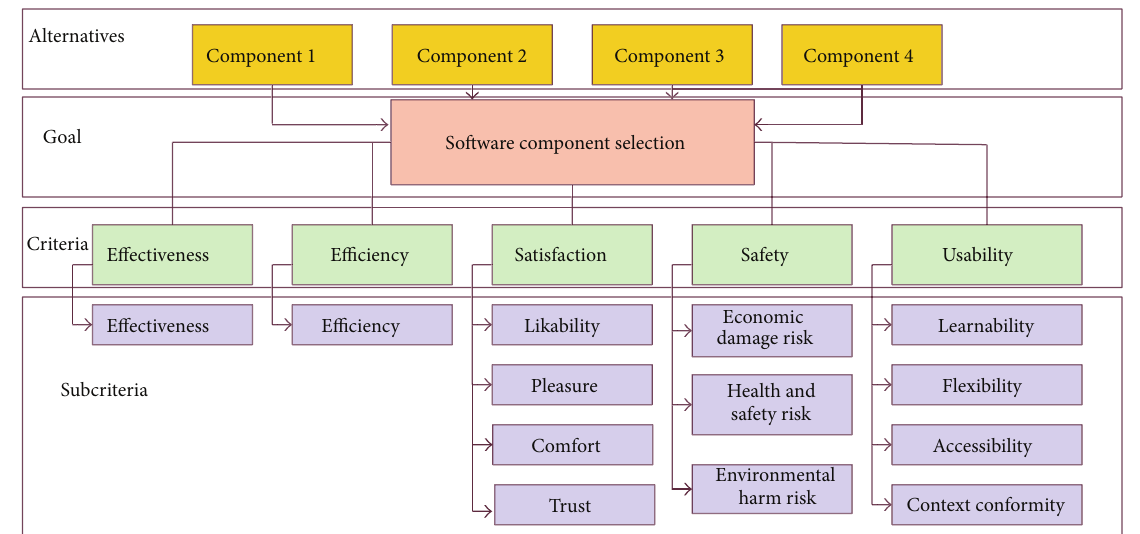
Figure 4: Proposed software component selection model based on ISO/IEC 25010:2011 using ANP.